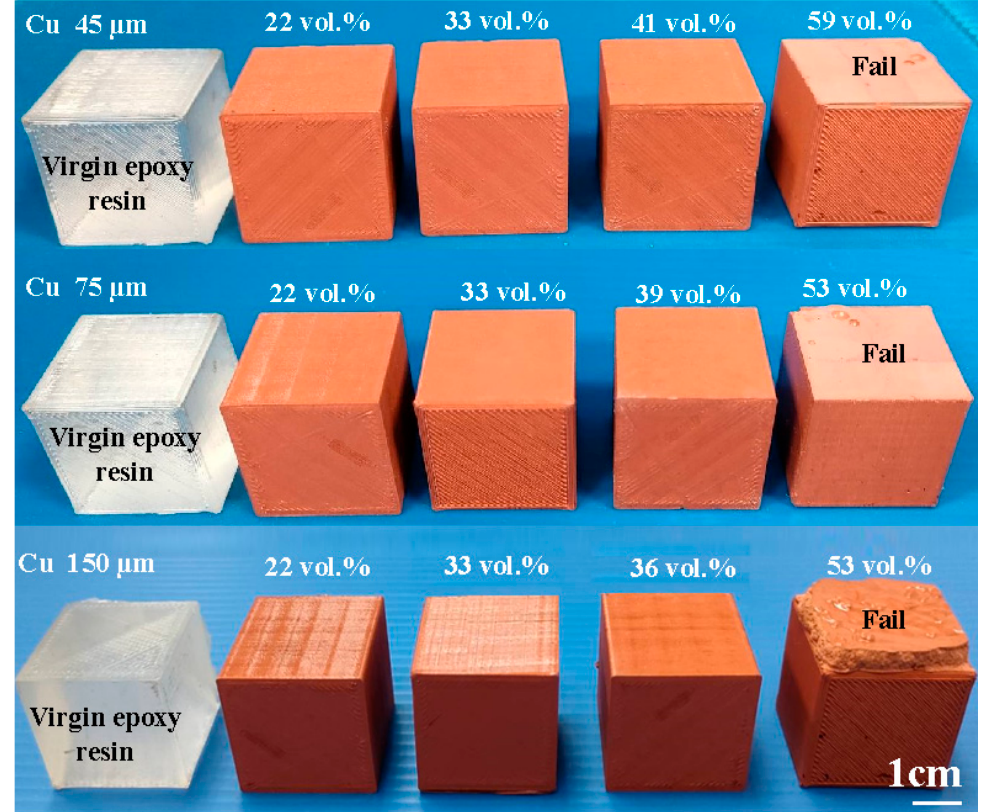
Figure 6. Formability results of the epoxy resin filled with three different powders with three different particle sizes.